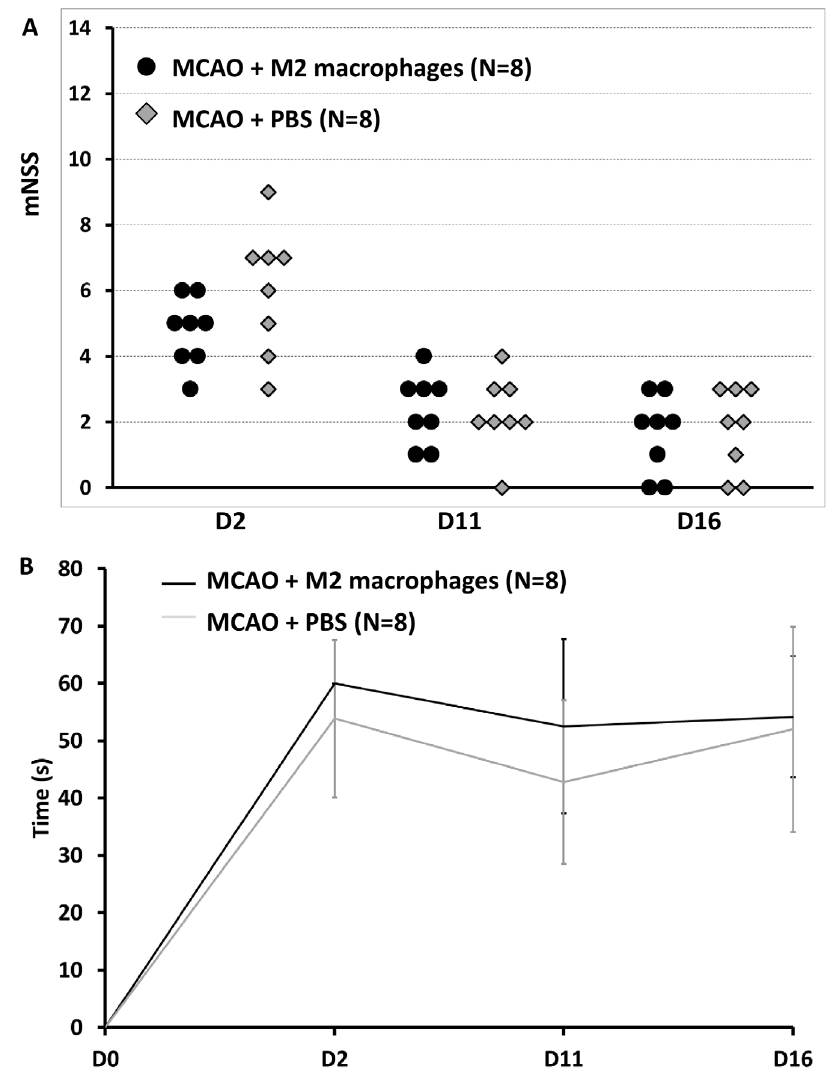
Figure 4. M2 macrophages do not improve functional outcome after ischemic stroke. A- mNSS test. B- Adhesive removal test. There was no statistical difference in rat performance before treatment (D2) for either behavioral test. After treatment (D11 and D16), there was an improvement in neuroscores in both treatment groups, but no statistically significant difference between them (analysis of variance for repeated measures, N=8 in each group, p=0.505). Similarly, time to remove the adhesive was slightly improved in both groups, without any significant difference (analysis of variance for repeated measures, N=8 in each group, p=0.699). PBS: phosphate-buffered saline (used as vehicle for cell delivery).